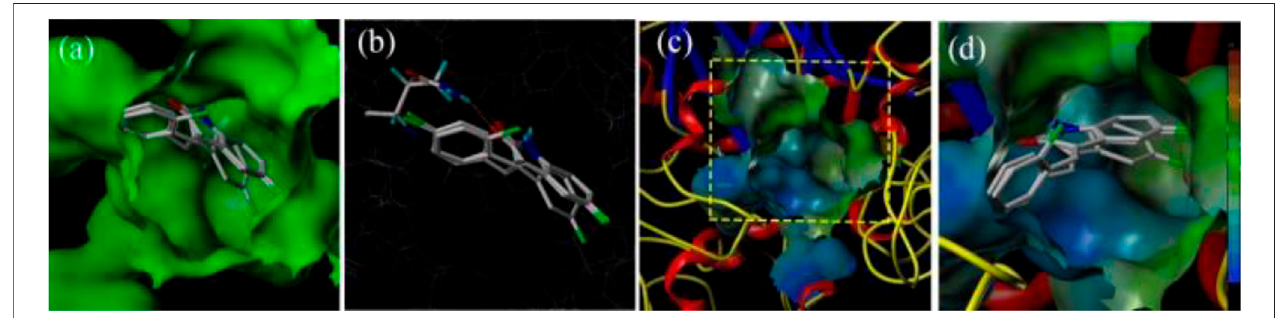
FIGURE 3 | (A) The insertion of compounds 3d , 3f , and 3i into the active pocket of α -glucosidase; (B) The hydrogen-bond interaction between carbonyl of the compounds ( 3d , 3f , and 3i ) and α -glucosidase; (C) The lipophilic interaction between the compounds ( 3d , 3f , and 3i ) and α -glucosidase; (D) The fl uorophenyl as the lipophilic fraction of compounds 3d , 3f , and 3i binding to α